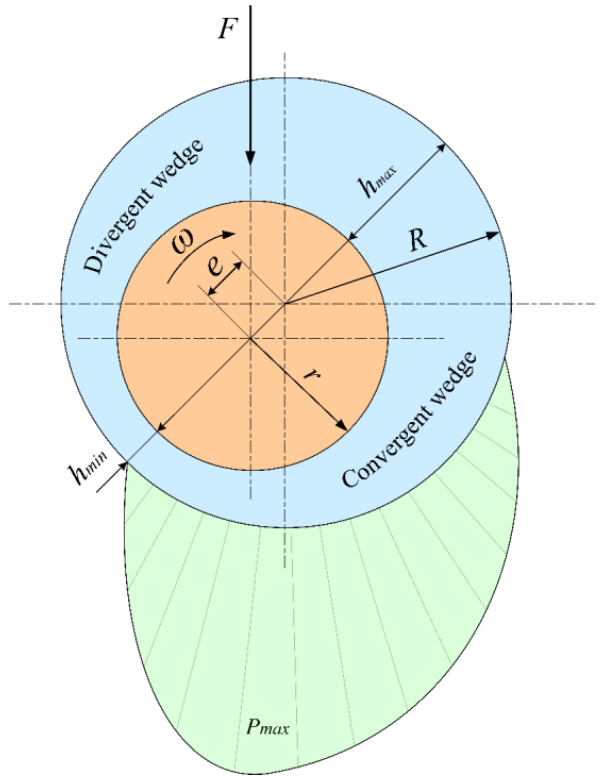
Figure 1. Distribution of oil pressure in radial plain bearings.